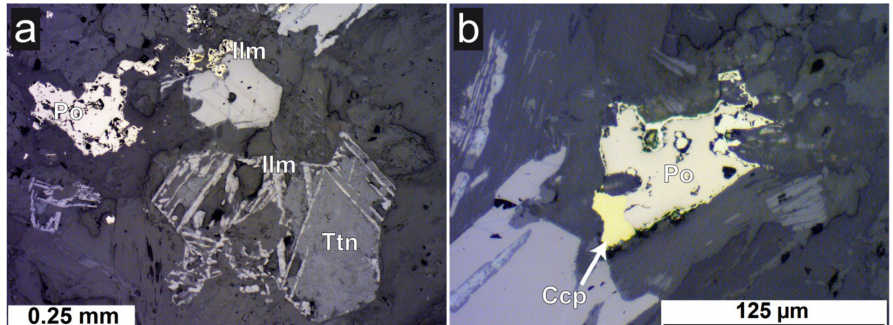
Figure 2. Photomicrographs of sample B1 in thin section. ( a ) Oriented ilmenite-rutile lamellae within titanite (Ttn), ilmenite (Ilm), and pyrrhotite (Po). ( b ) Polyphase sulphide grain with chalcopyrite (Ccp, yellow, with red arrow), pyrrhotite (Po) the latter with a reaction rim of another Fe sulphide; both images reflected light, plane parallel polarizers.